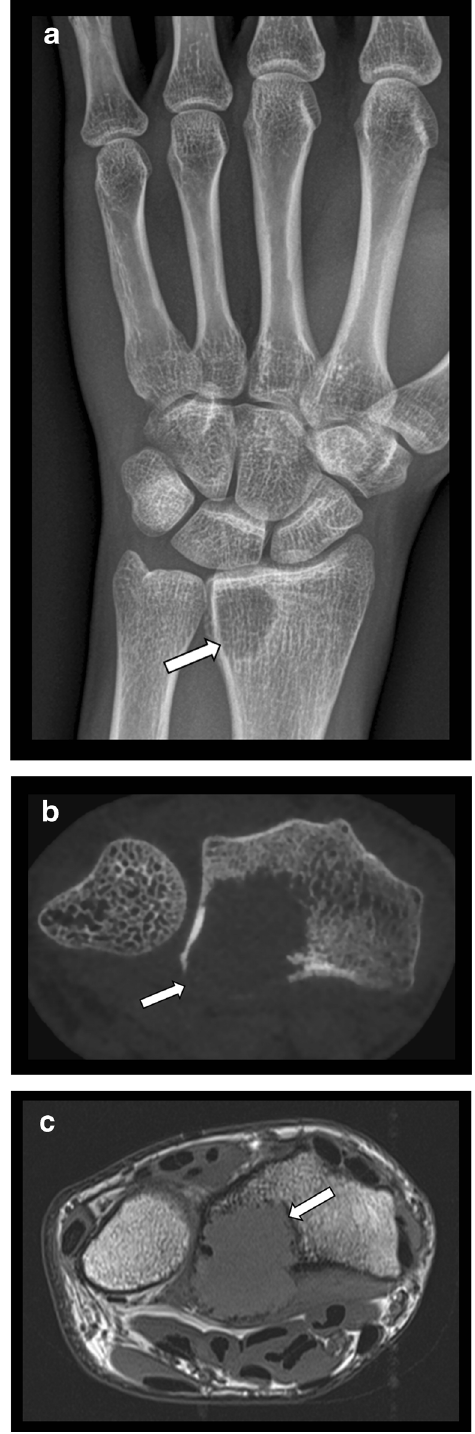
Fig. 6 Giant cell tumour of distal radius. a . CR (AP view) showing an osteolytic lesion in the distal epiphysis of the radius (arrow). There is no major cortical breakthrough visible on CR. b . Axial CBCT reconstruction clearlyshow cortical breakthroughof thelesion. The precise extent ofthe soft tissue involvement is inaccurate due to insufficient soft tissue contrast. c . On axialT1-WI MRI,thelesionisisointensetomusclewithcorticaldisruptionat the volar aspect and involvement of pronator quadratus muscle. MRI is far superior for evaluation of the soft tissue component of the lesion